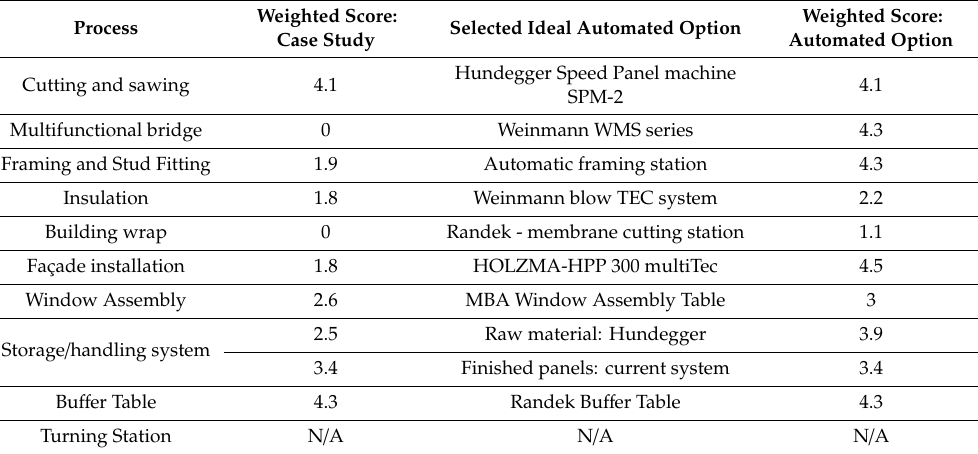
Table 14. Summary of MCA